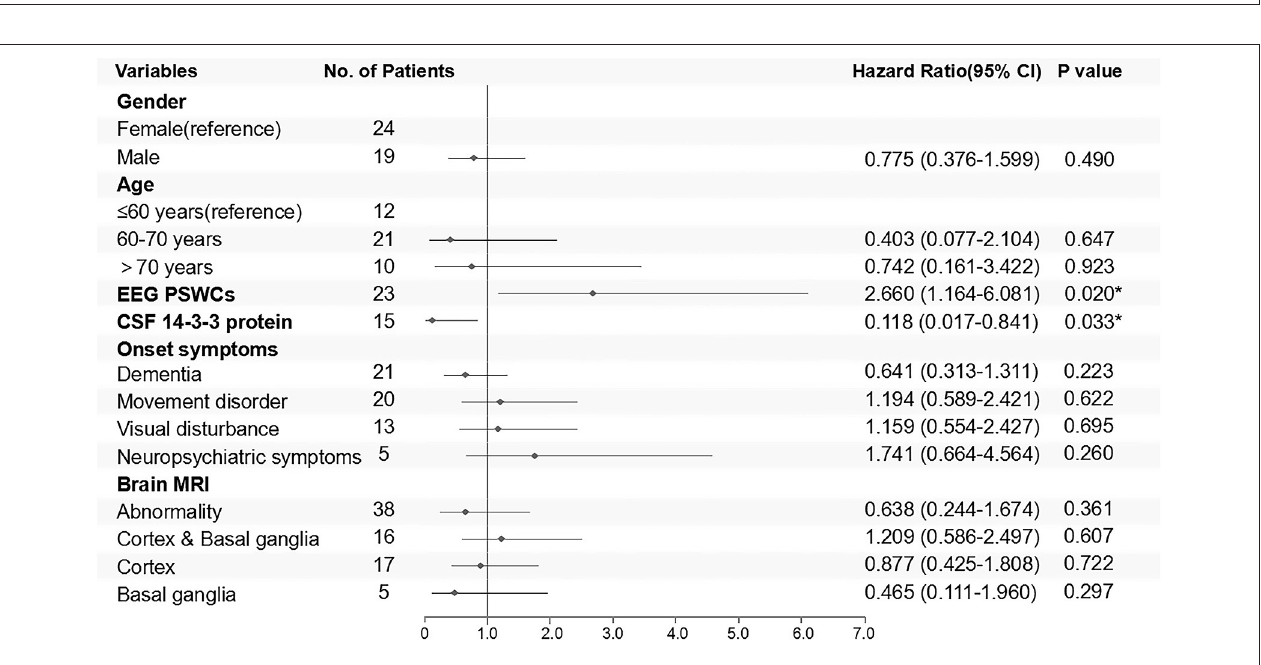
FIGURE 5 | The Kaplan–Meier survival curves for deceased patients. The X-axis represents survival time (months), and the Y-axis represents survival probability. (A) Survival time for patients stratified by gender. (B) Survival time for patients stratified by age. Graphic symbol shows the median survival time (50% percentile) of the distinct gender or age groups.